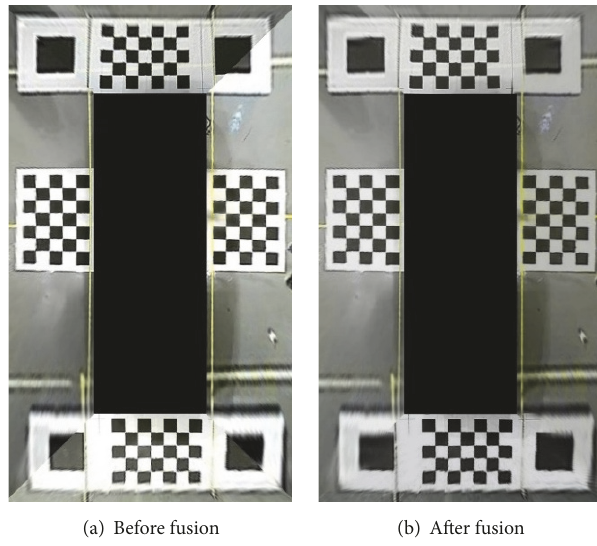
Figure 9: Stitched bird view image of